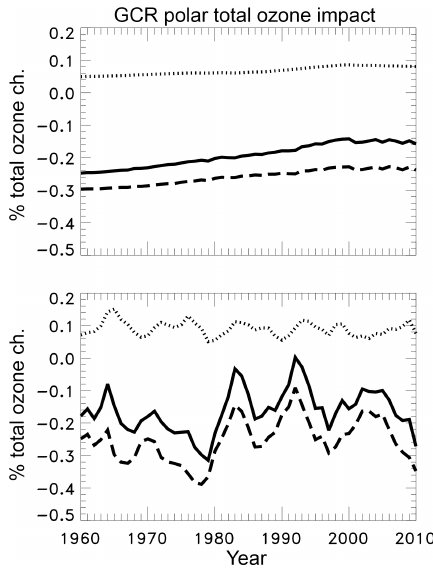
Figure 9. GSFC 2-D model GCR-computed impacts of annual aver- age polar total ozone (AAPTO) between 1000 and 100hPa (dotted black), between 100 and 1hPa (dashed black), and for the entire troposphere and stratosphere, 1000 to 1hPa, (solid black) over the 1960–2010 time period. The top plot shows the comparison of sim- ulation A1_GCR_GSFC to A_ Base_GSFC . The bottom plot shows the comparison of simulation E_GCR_GSFC to E_Base_GSFC